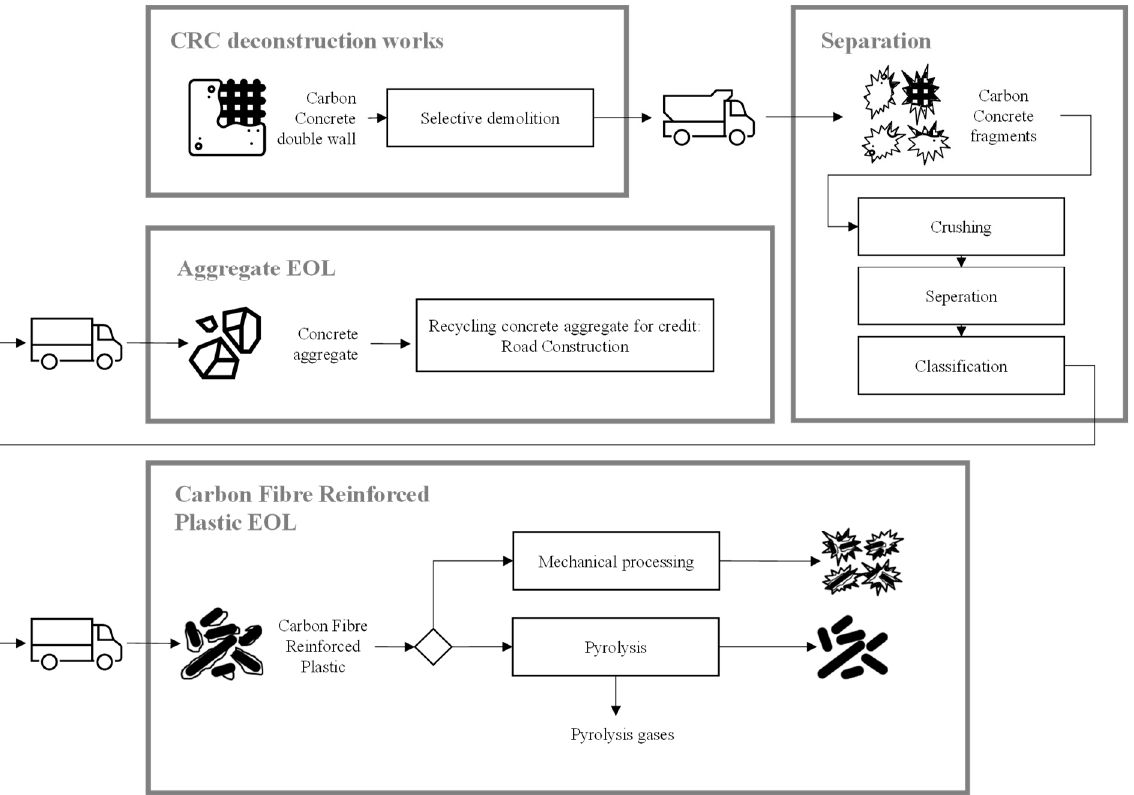
Figure 1. Processes to recycle CRC.